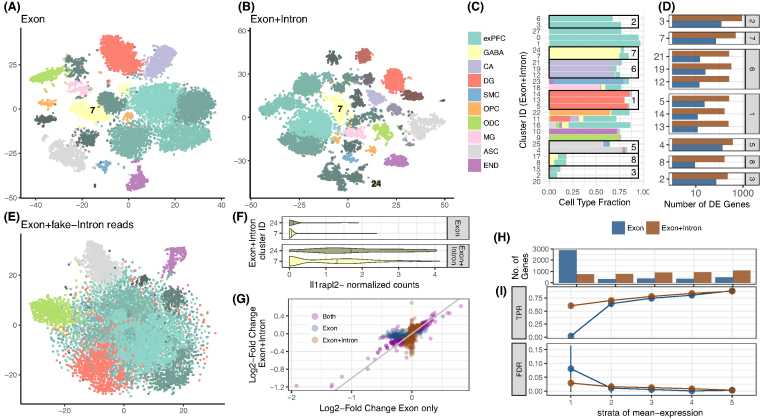
Contribution of intron reads to biological insights. We analyzed published single-nucleus RNA-seq data from mouse prefrontal cortex (PFC) and hippocampus [12] to assess the utility of counting intron in addition to exon reads. We processed the raw data with zUMIs to obtain expression tables with exon reads as well as exon+intron reads and then used the R-package Seurat [35, 36] to cluster cells. With exon counts, we identified 19 clusters (A), and with exon+intron counts we identified 27 clusters (B). Clusters are represented as t-SNE plots and colored according to the most frequent cell-type assignment in the original article [12]: glutamatergic neurons from the prefrontal cortex (exPFC), GABAergic interneurons (GABA), pyramidal neurons from the hippocampal CA region (CA), granule neurons from the hippocampal dentate gyrus region (DG), astrocytes (ASC), microglia (MG), oligodendrocytes (ODC), oligodendrocyte precursor cells (OPC), neuronal stem cells (NSC), smooth muscle cells (SMC) and endothelial cells (END). Different shades of those clusters indicate that multiple clusters had the same major cell type assigned. If we randomly sample counts from the intron data and add them to the exon counting, the noise reduces the number of clusters and the Seurat pipeline can only identify 9–11 clusters (E). The composition of each cluster based on exon+intron is detailed in panel (C), and cells that were not assigned a cell type in [12] are displayed as empty. The boxes mark the clusters that were not split when using exon data only. For example, cluster 7 from exon counting, which mainly consists of GABAergic neurons, was split into clusters 7, 24 (506, 66 cells) when using exon+intron counting. In (D), we show the numbers of genes that were differentially expressed (DE) (limma p-adj <0.05) between the clusters found only with exon+intron counts. The panel numbers represent the exon counting cluster numbers and the y-axis the exon+intron counting cluster number. The log2-fold changes corresponding to these contrasts are also used in (G). Among the genes that were additionally detected to be DE by exon+intron counting was the marker gene Il1rapl2 (limma p-adj = 10−5). In (F), we present a violin plot of the normalized counts for Il1rapl2 in cells of the GABAergic subclusters 7 and 24. Log2-fold changes calculated with exon+intron counts correlate well with exon counts (G). Note that for exon counting only, half as many genes could be evaluated as for exon+intron counting and thus only half of the exon+intron genes are depicted in (G). Large log2 fold changes (LFCs) are found to be significant with both counting strategies (purple points are close to the bisecting line). We conducted simulations based on mean and dispersion measured using exon cluster 0 (1,616 cells, ∼90% exPFC). In (I) we show the expected true positive rate and the false discovery rate for a scenario comparing 300 vs 300 cells. Results for exon and exon+intron counting were stratified into five quantiles according to the mean expression of genes, where stratum 1 contains lowly expressed genes and stratum 5 the most highly expressed genes. The numbers of genes falling into each of the bins using exon+intron and exon counting are depicted in (H).